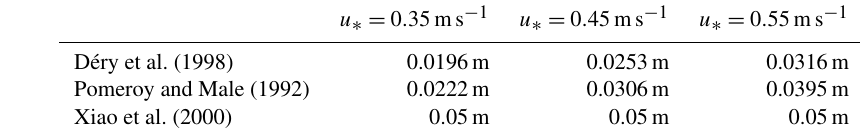
Table 3. The height below which most of the saltating particles were distributed at various friction velocities. u ∗ = 0 . 35ms − 1